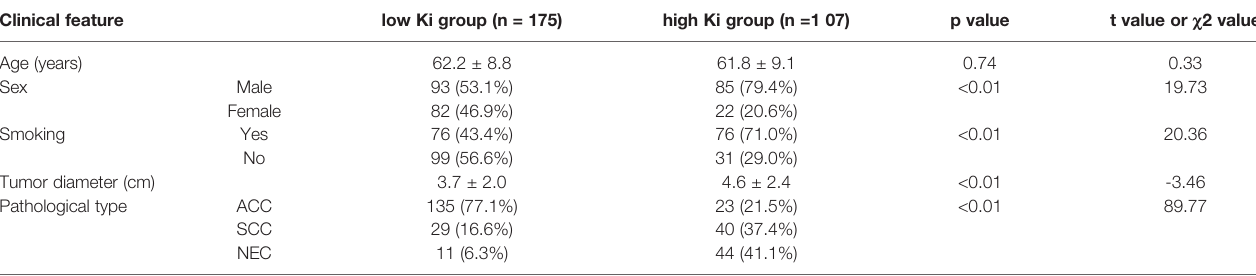
TABLE 2 | Comparison of the clinical data results between the low Ki-67 and high Ki-67 lung cancer groups. Clinical